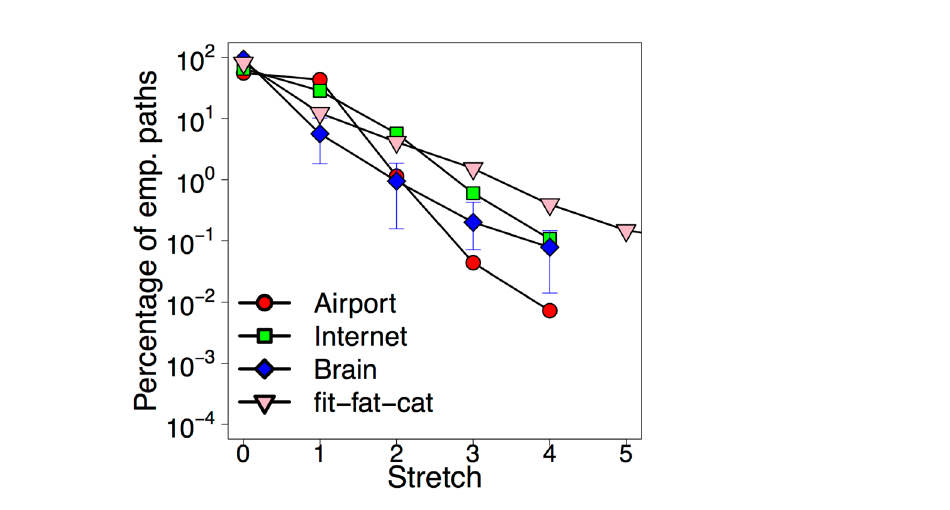
Figure 2. Stretch of the empirical paths with respect to their shortest counterparts. While most of the empirical paths exhibit zero stretch (confirming the shortest path assumption), a large fraction (20–40%) of the paths is “inflated” even up to 4–5 hops. The plot indicates a stunning resemblance in the distribution of path stretch in our